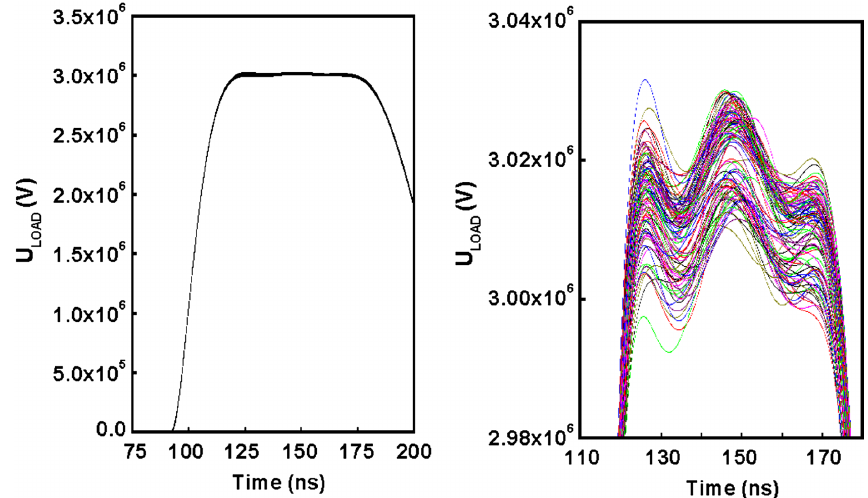
FIG. 9. The left graph shows the output pulses across the 23.7 Ohm load of the module consisting of 30 LTD cavities connected in series with 5th harmonics in 11 S þ 7 M þ 2 F configuration, which are simulated with σ 1 T ¼ 0 . 5 ns, σ 1 L = right graph shows the tops of 80 pulses in more